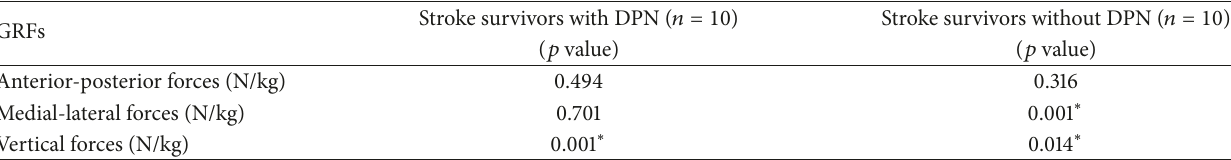
Table 3: Comparison of GRFs of the paretic and nonparetic side.